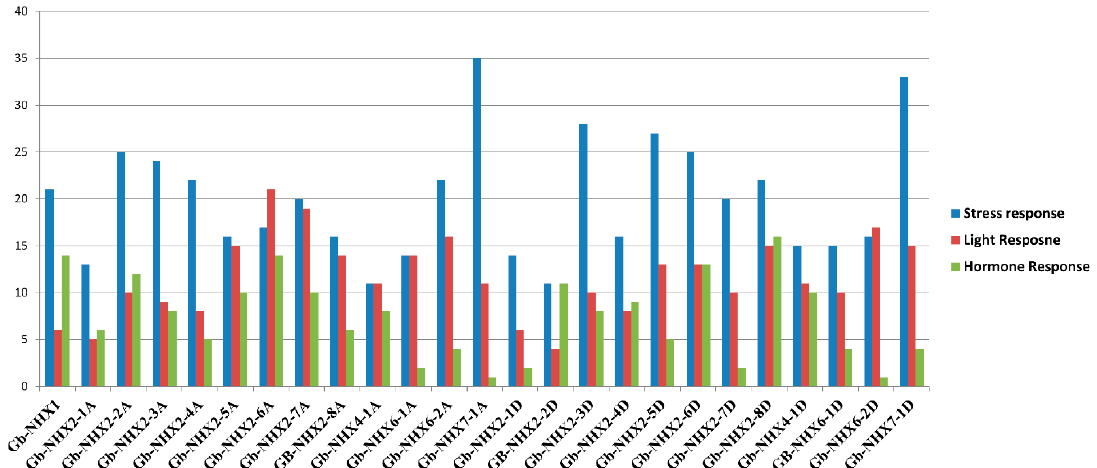
Figure 5. Cis-elements of the NHX transporters. Vertical axis represents the number of Cis-elements, and the horizontal axis shows the genes name.